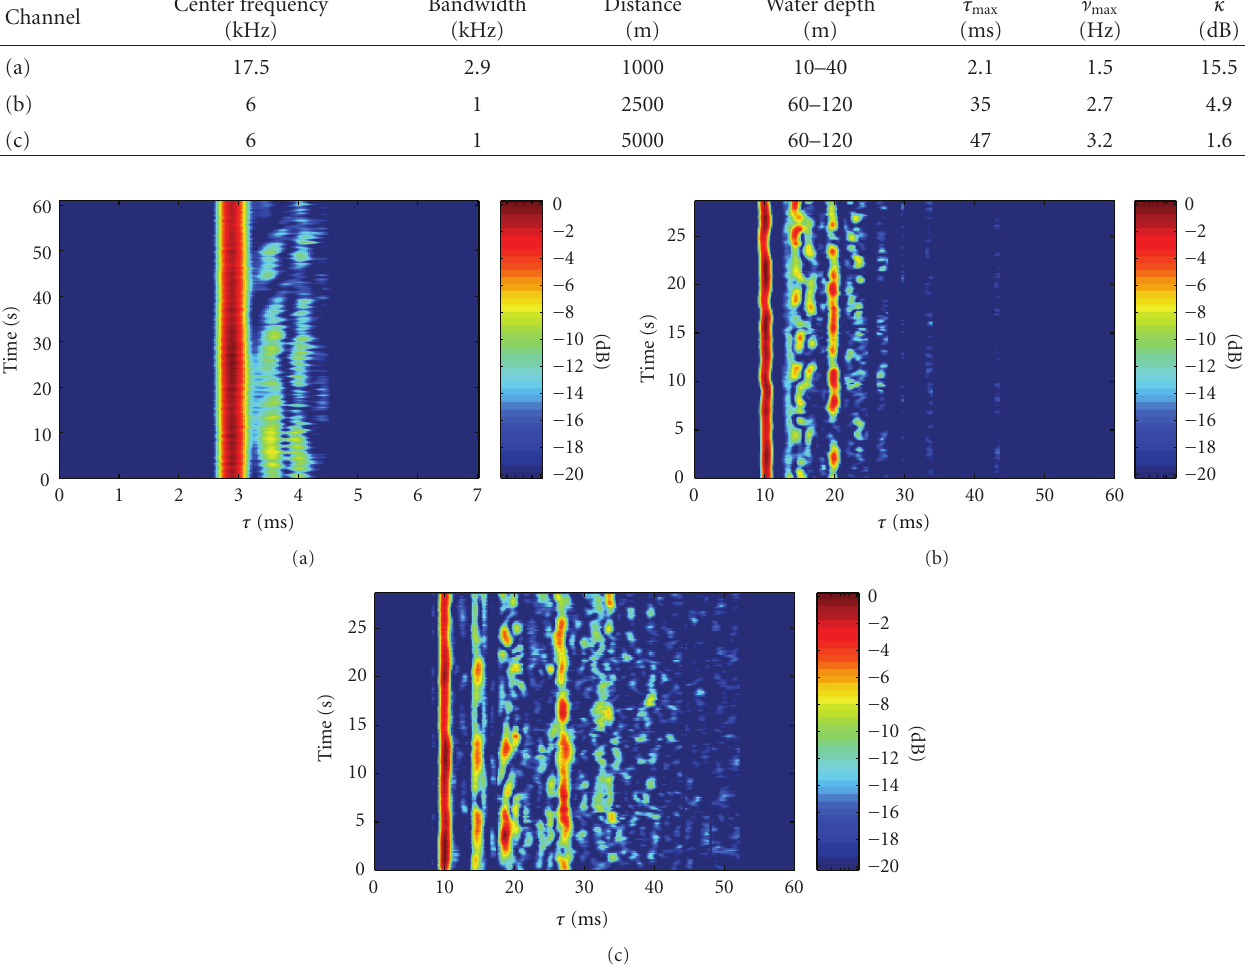
Figure 2: Time evolution of the power delay profiles of the channels depicted in Table 1.